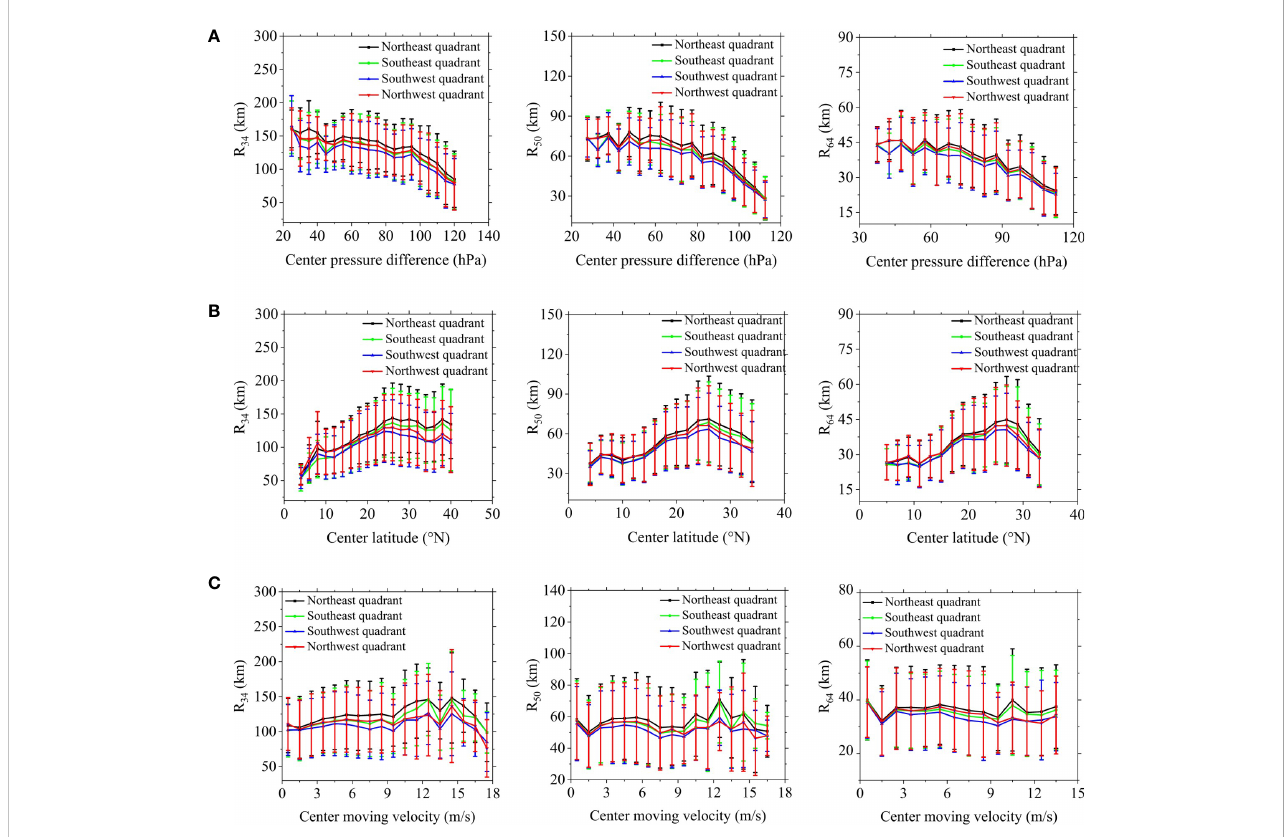
FIGURE 1 Distribution map of the radii of wind and: (A) the central pressure difference of the typhoon, (B) the central latitude of the typhoon, (C) the central moving velocity of the